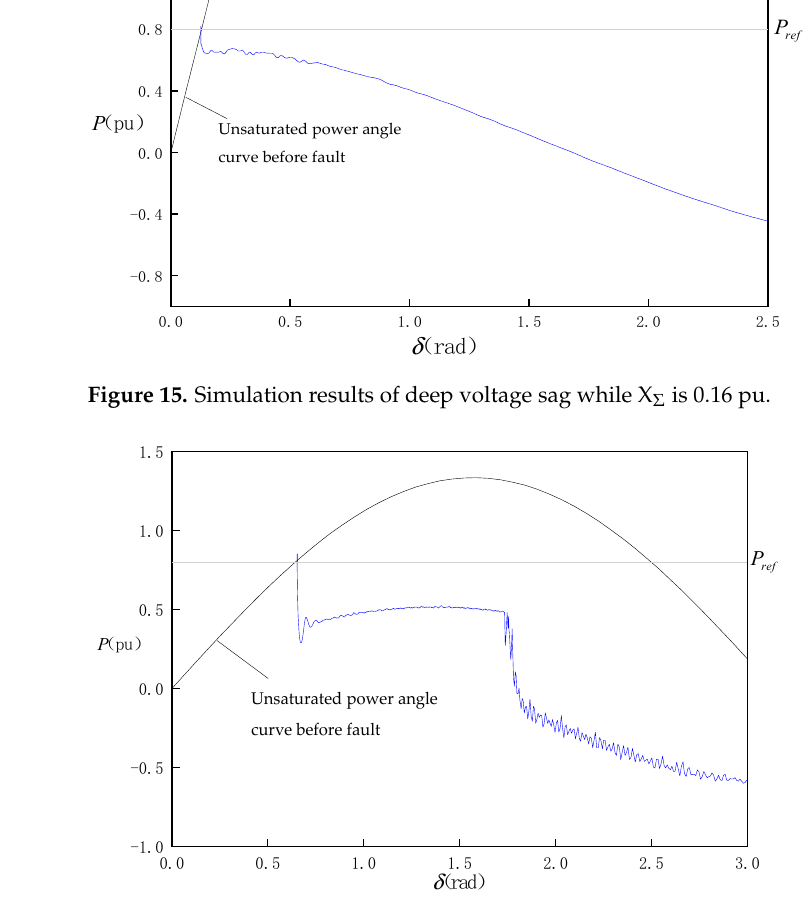
Figure 16. Simulation results of deep voltage sag while X Σ is 0.75 pu.